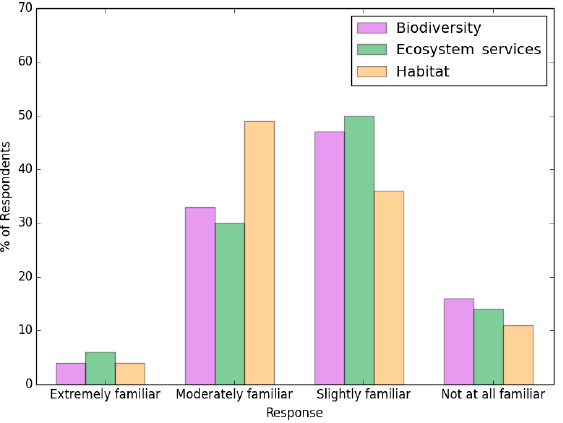
Figure 4. Survey results related to awareness about biodiversity, ecosystem services, and habitat. Int. J. Environ. Res. Public Health 2016 , 13 , 1169